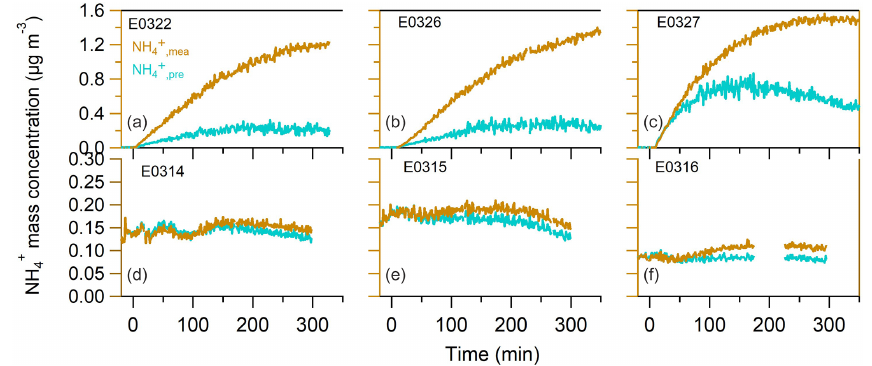
Figure 2. The time series of measured and predicted ammonium in the nucleated SOA (a–c) and in the seeded SOA experiments (d–f) .